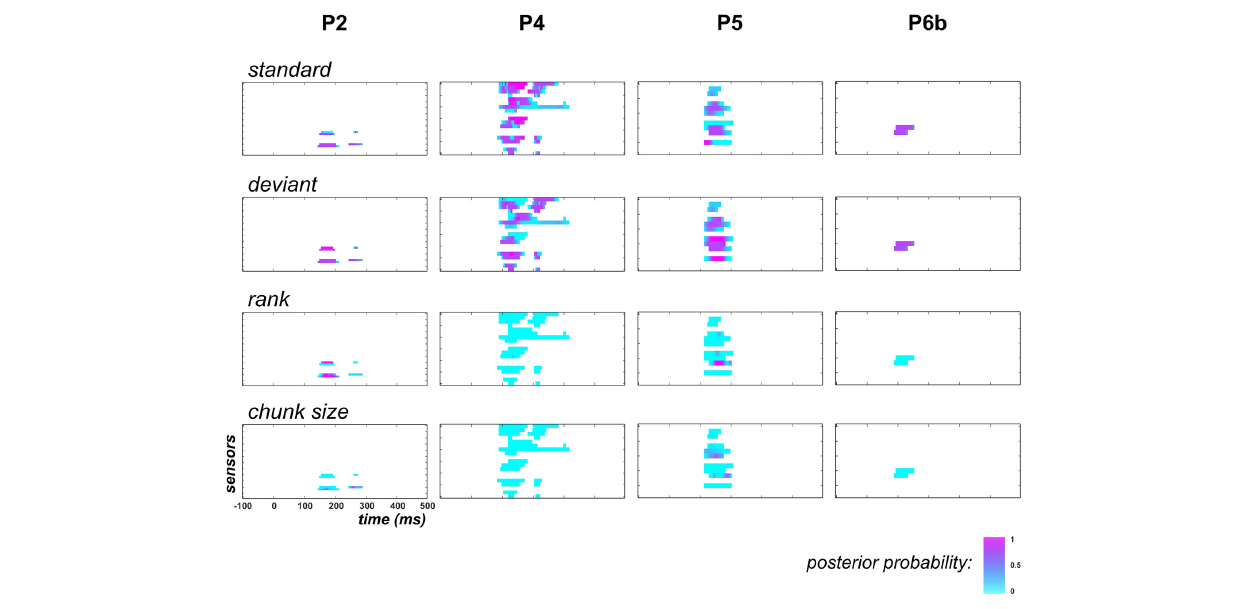
FIGURE 7 | Family-level inference in posterior temporal region when learning is removed from the GLM (UC and PC). Following the display in Figure 6 , each individual map shows the posterior probability at posterior temporal sensors and at each peri-stimulus time point for families X std static = ON ( top row ), X dev static = ON (upper central), X rank exp = ON ( lower central ) and X cs exp = ON ( bottom ).